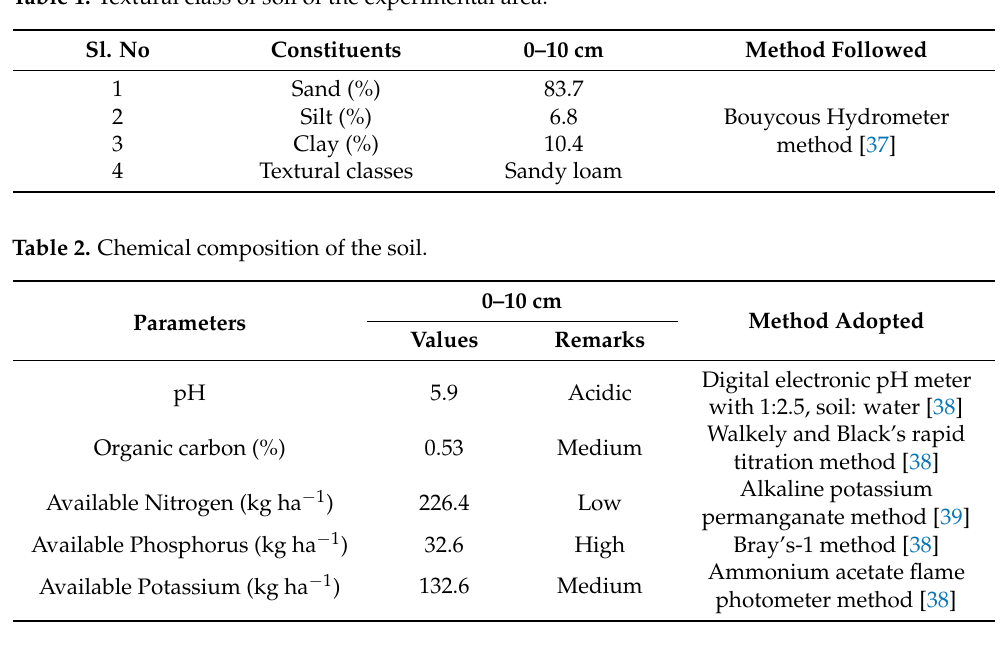
Table 1. Textural class of soil of the experimental area.